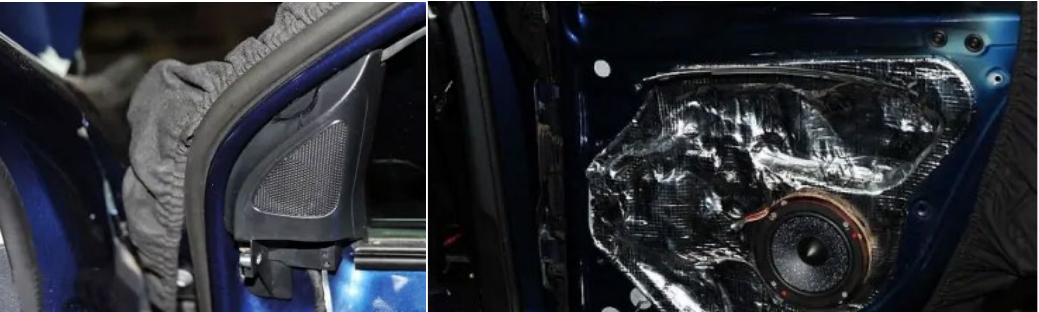
Figure 1. Volkswagen Golf with sound enhancement system.